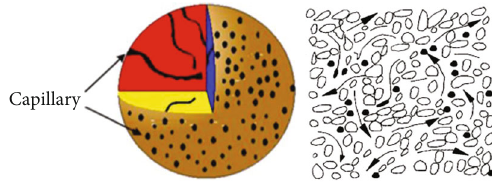
Figure 1: A capillary spherical model of coal particle.